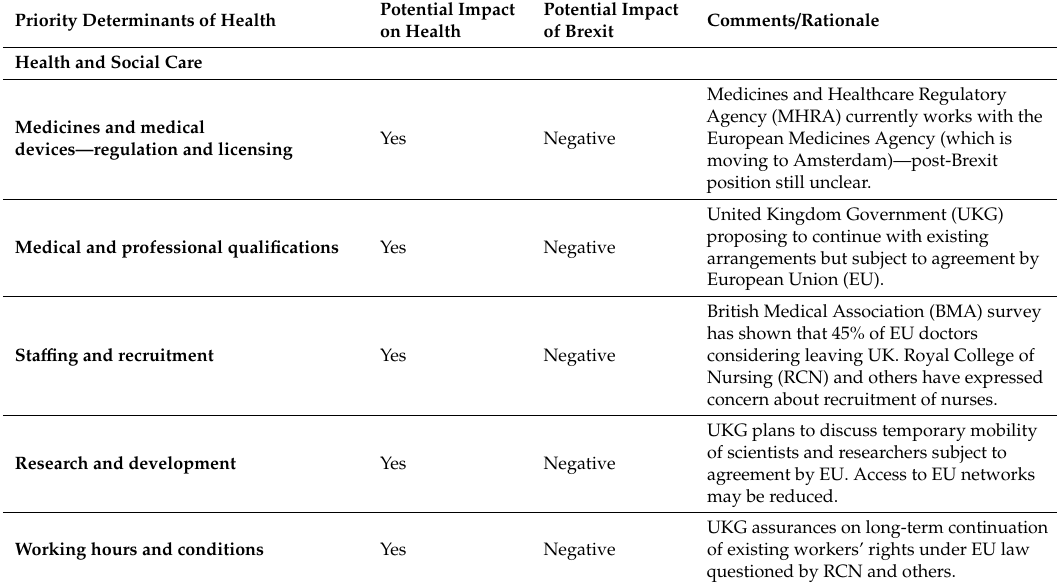
Table A1. Example of summary screening paper—list of prioritised determinants of health to be investigated